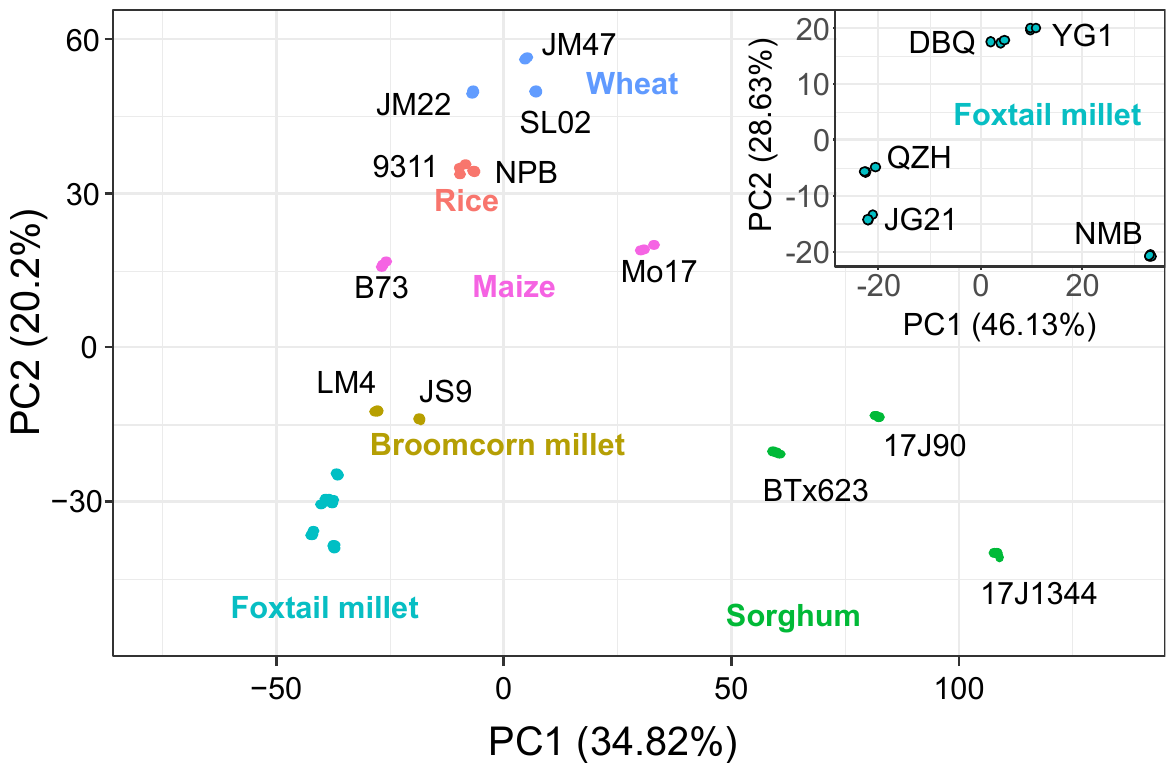
Figure 2. The PCA plot of flavonoids and carotenoids in all samples.